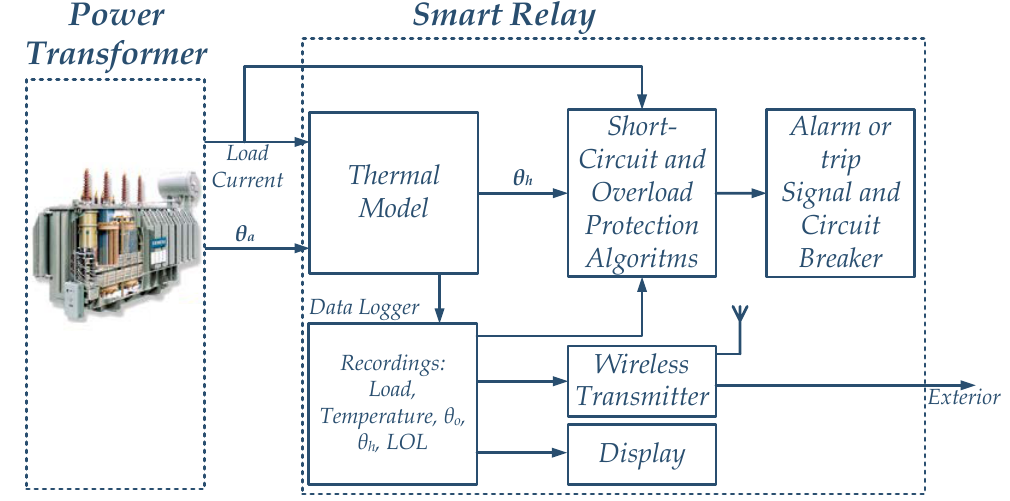
Figure 6. The proposed smart transformer